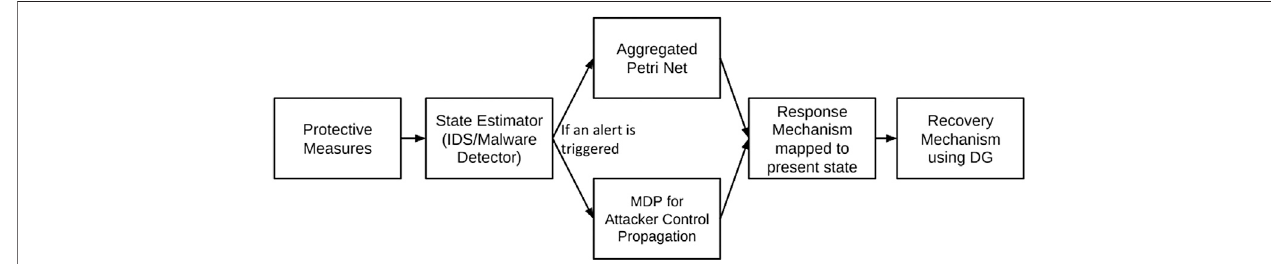
FIGURE 6 | Flow chart for attack detection and mapping.